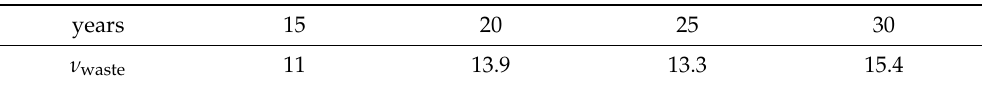
Table 7. Waste impact ratio between RESCATAME and baseline